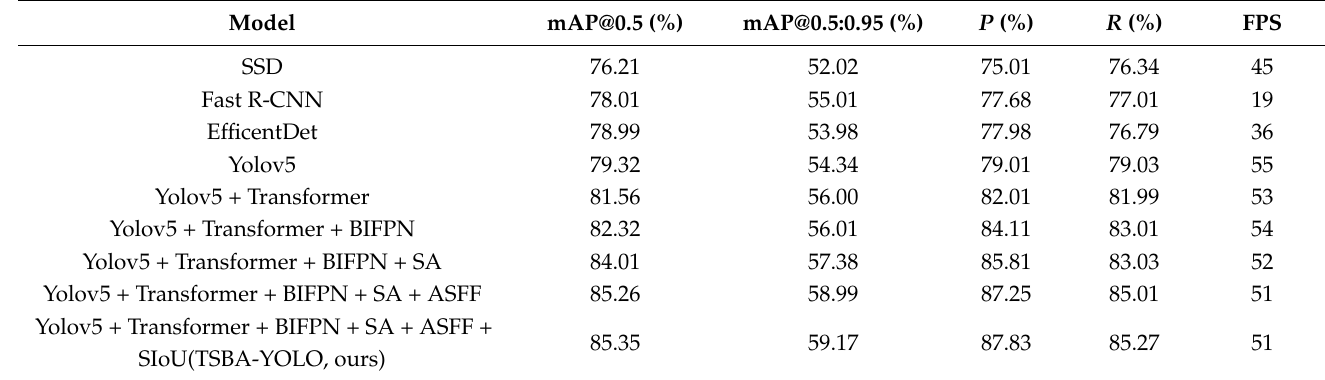
Table 2. Ablation experiment